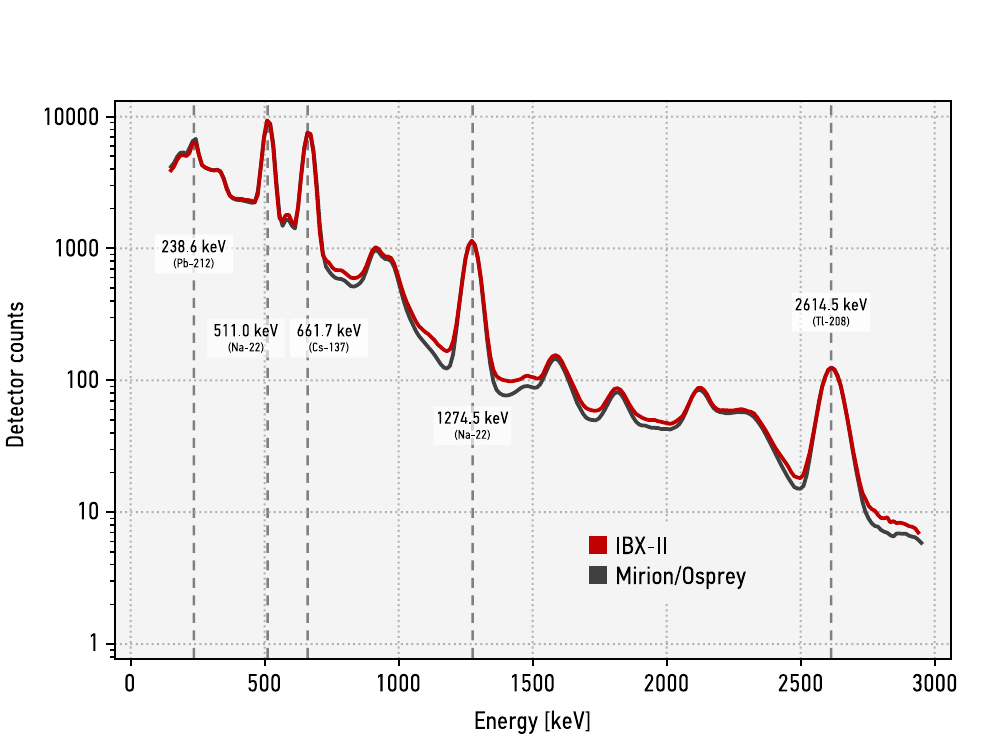
Fig 3. IBX II (256-channel) gamma spectrum compared to a spectrum acquired with a modern detector system. A few prominent gamma energies are highlighted. Shown spectra are averaged data from 150 standard measurements with 2 18 events each.